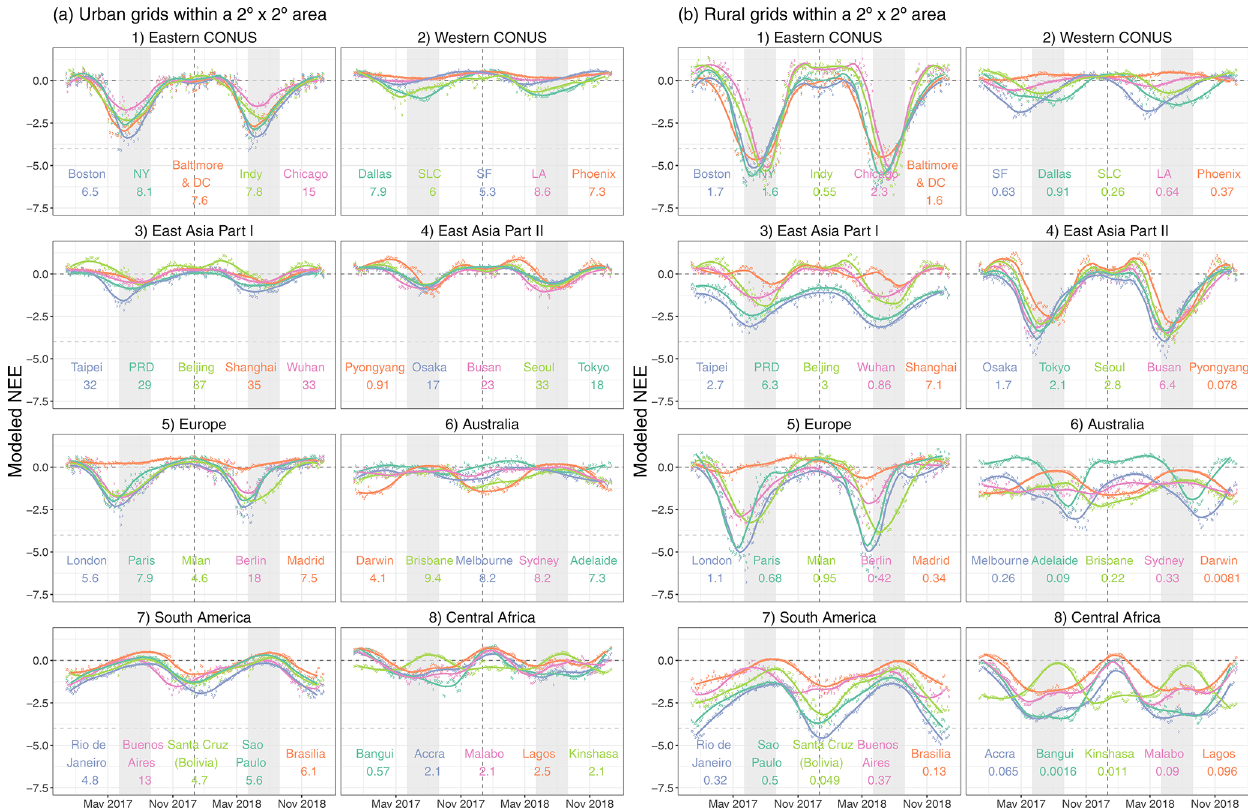
Figure 7. A multi-city comparison of the spatially averaged NEE fluxes [µmolm − 2 s − 1 ] over urban (a) and rural (b) grid cells within a 2 ◦ × 2 ◦ area around the urban center for 2017–2018. We present the 4d mean (in circles) and monthly mean (smoothed splines) NEE for 40 selected cities in CONUS, western Europe, East Asia, eastern Australia, South America, and central Africa. Light gray ribbons indicate the typical northern hemispheric summer months (June–August, JJA). The numbers below city names denote the spatially averaged fossil fuel CO 2 emissions derived from ODIAC over the same grid cells as